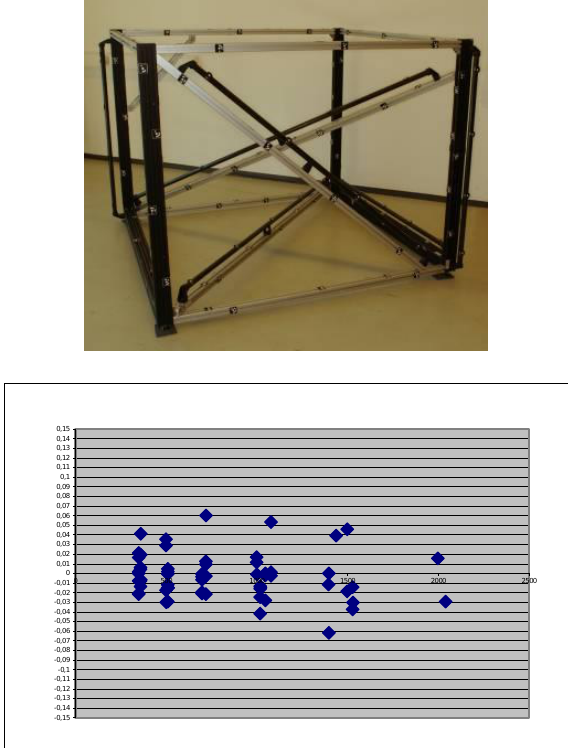
Figure 8: Test field at AICON (above) and typical example of a length measurement error